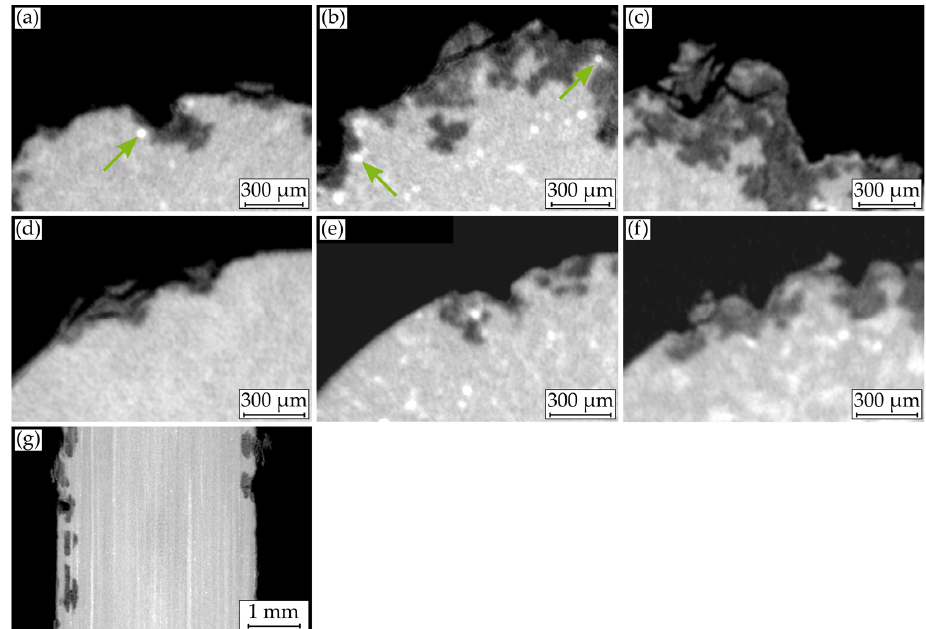
Figure 11. µ-computed tomography images after immersion tests with galvanostatic anodic polari- Figure 11. µ -computed tomography images after immersion tests with galvanostatic anodic